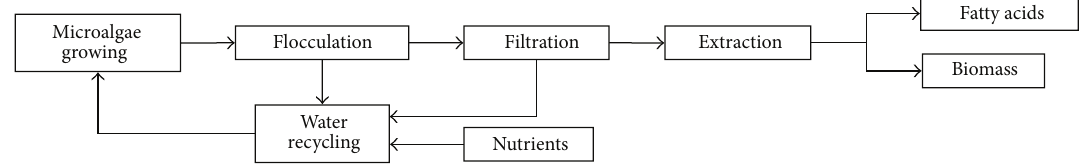
Figure 1: Scheme of the algal treatment with the individual